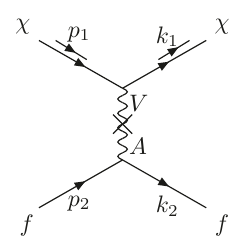
Figure 3. The leading diagram of the χ − f scattering when there is a generic kinetic mixing term for the gauge